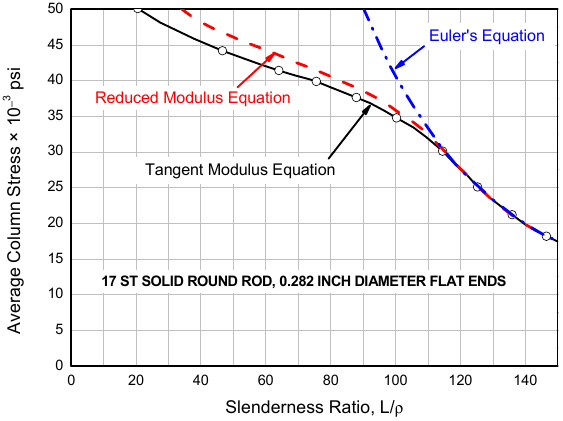
Figure 3. Comparison of experimental data and column theories.